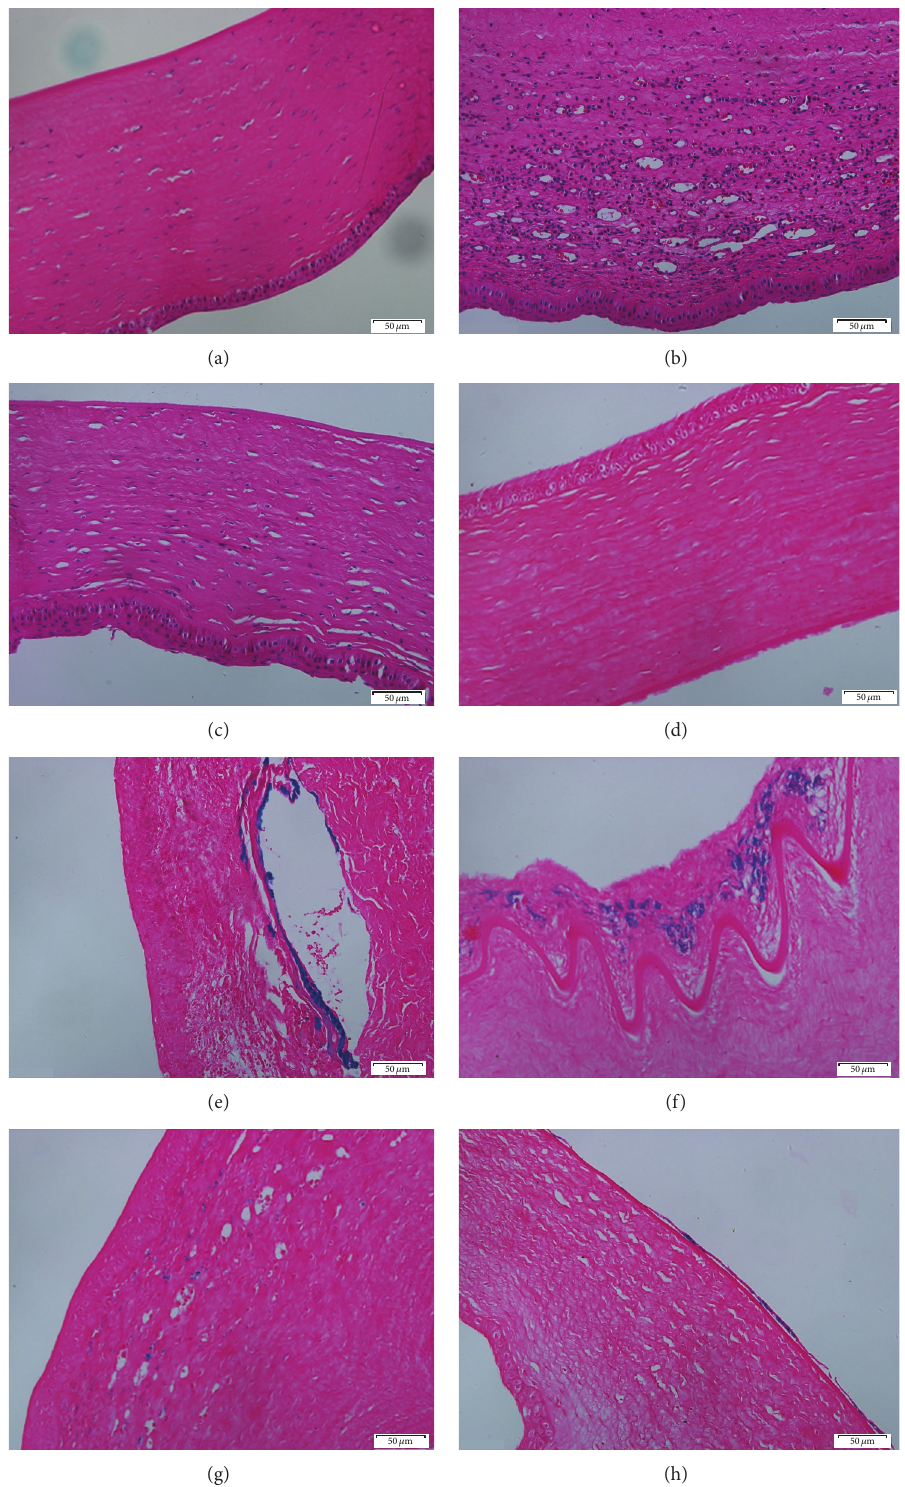
Figure 4: Histological examination of cornea. Hematoxylin and eosin (H&E) staining of cornea from control group (a) and the iron- containing IOFB modeling group with 0mA (b) and 0.4 mA RI treatment (c). Prussian blue iron staining of cornea from normal control group (d) and the iron-containing IOFB modeling group with 0mA (e and f) and 0.4 mA RI treatment (g and h). (Original magnification, 20x. Scale bar, 50 𝜇